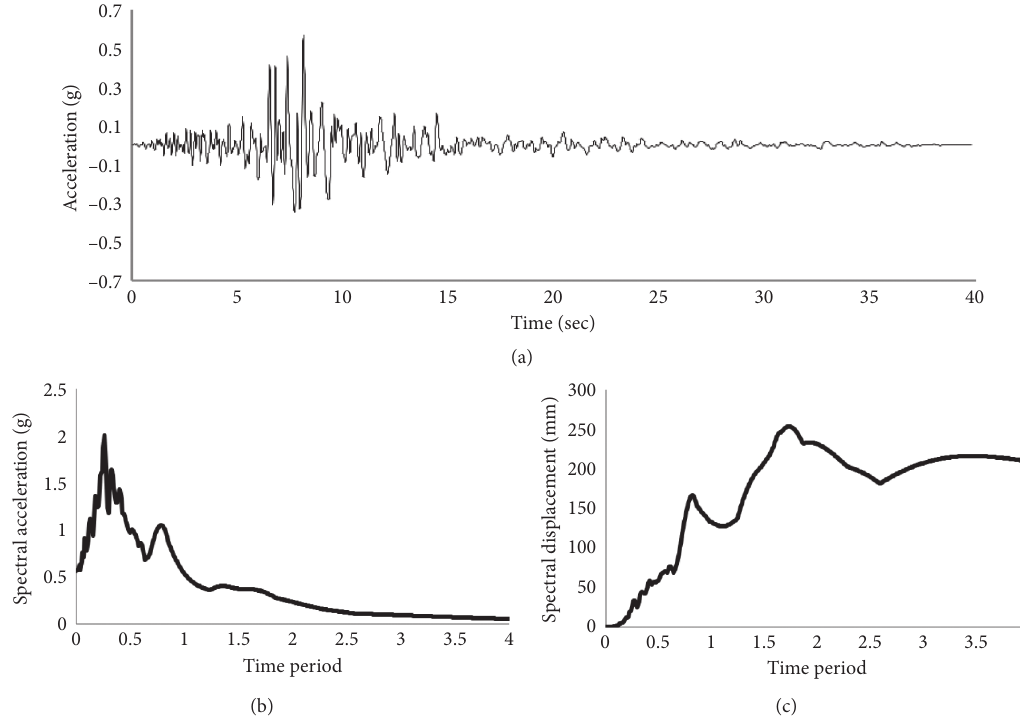
Figure 6: Natural accelerogram of 1994 Northridge earthquake used for shake table testing. (a) Northridge 1994 acceleration time history. (b) 5% damped acceleration response spectra. (c) 5% damped displacement response spectra.